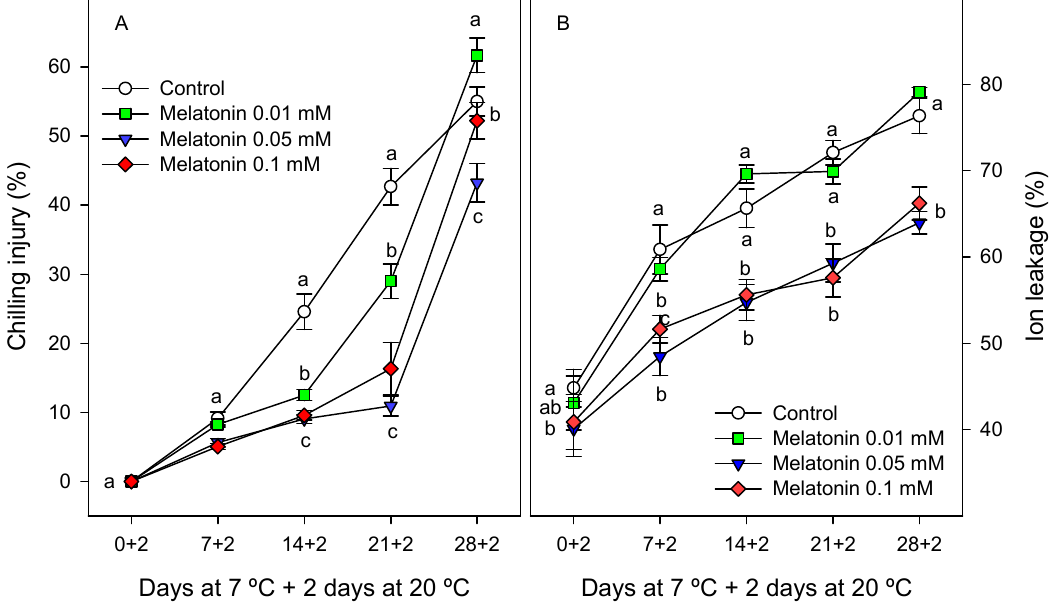
Figure 1. Chilling injury ( A ) and ion leakage ( B ) in cherimoya peel as affected by melatonin (0.01, 0.05 and 0.1 mM) treatments. Data are the mean ± SE of three replicates. Different letters show significant differences ( p < 0.05) among treatments for each sampling date.